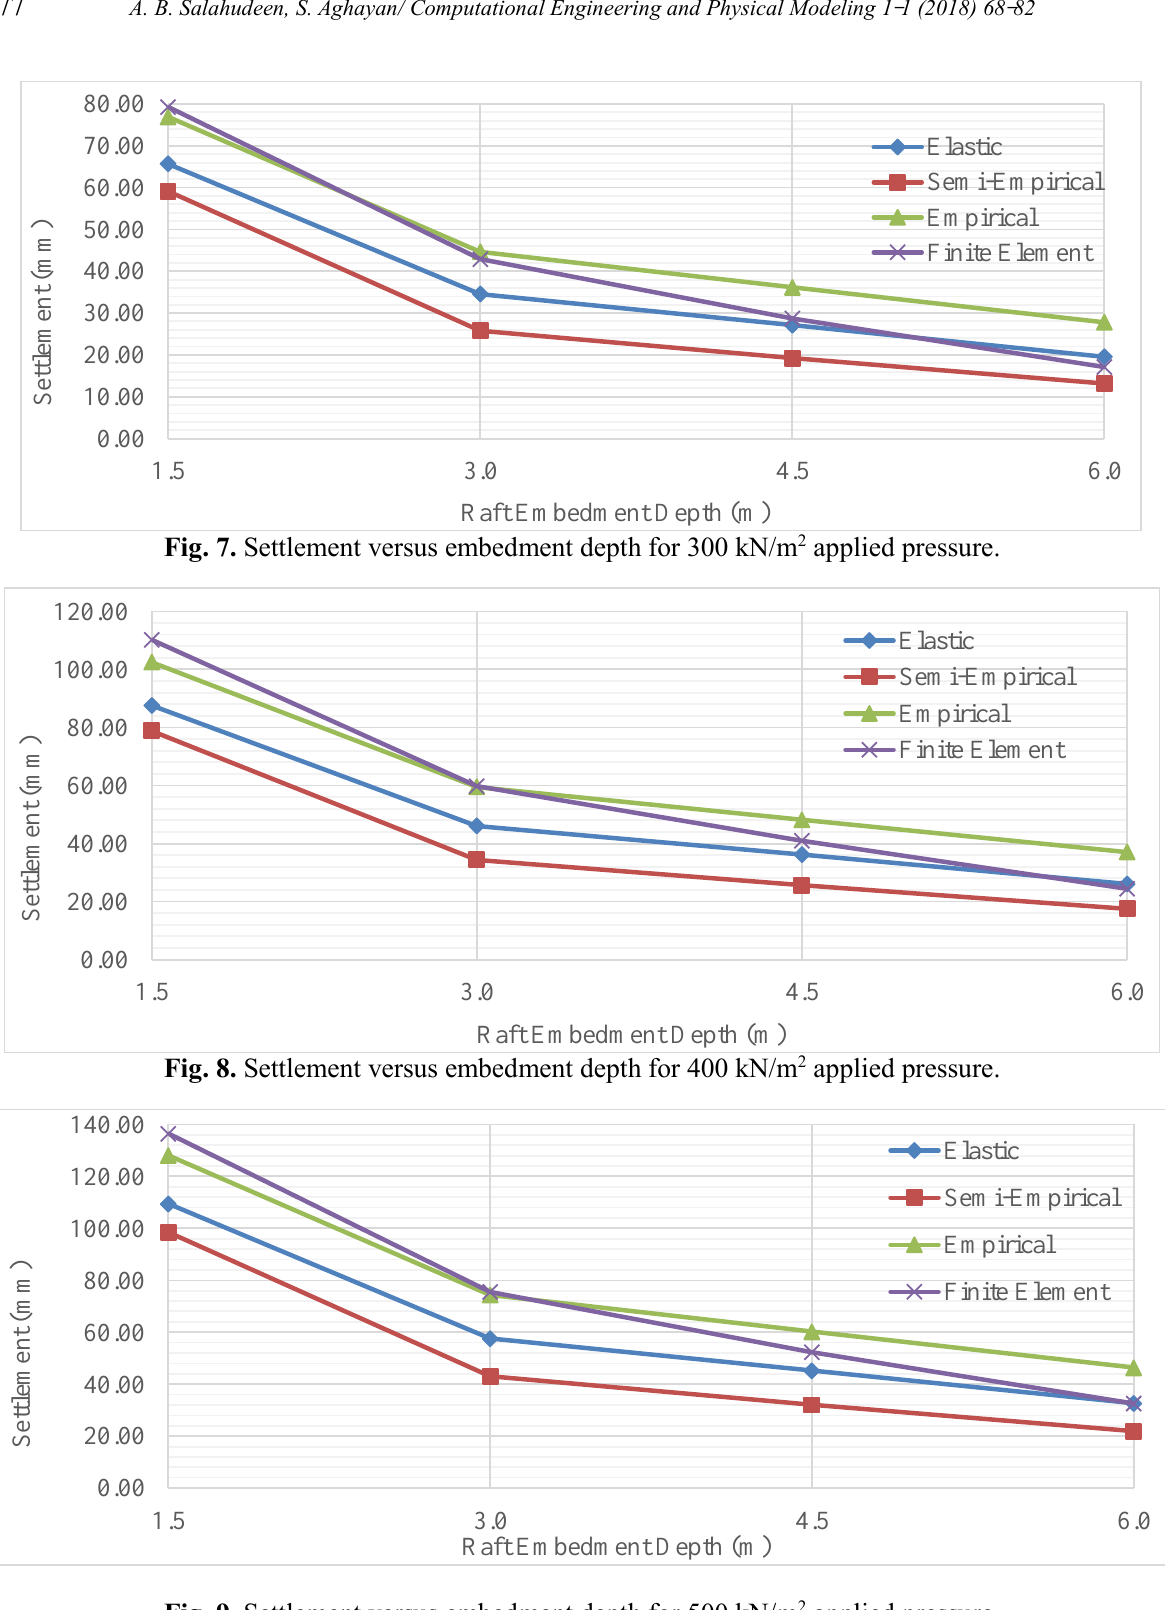
Fig. 9. Settlement versus embedment depth for 500 kN/m 2 applied